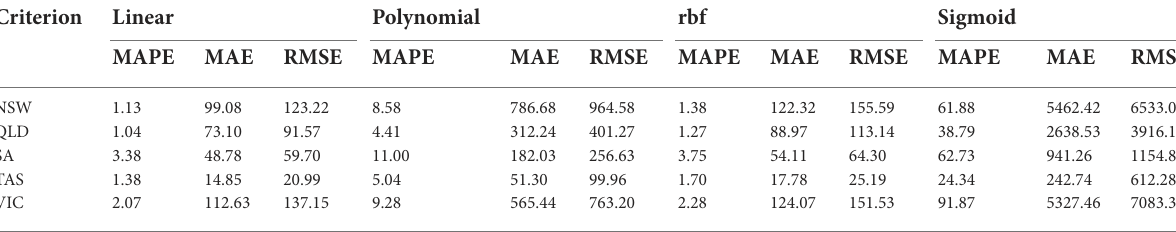
TABLE 3 PerformanceoftheSVRwithdifferentkernelfunctionsbasedonMAPE,MAE,andRMSE.